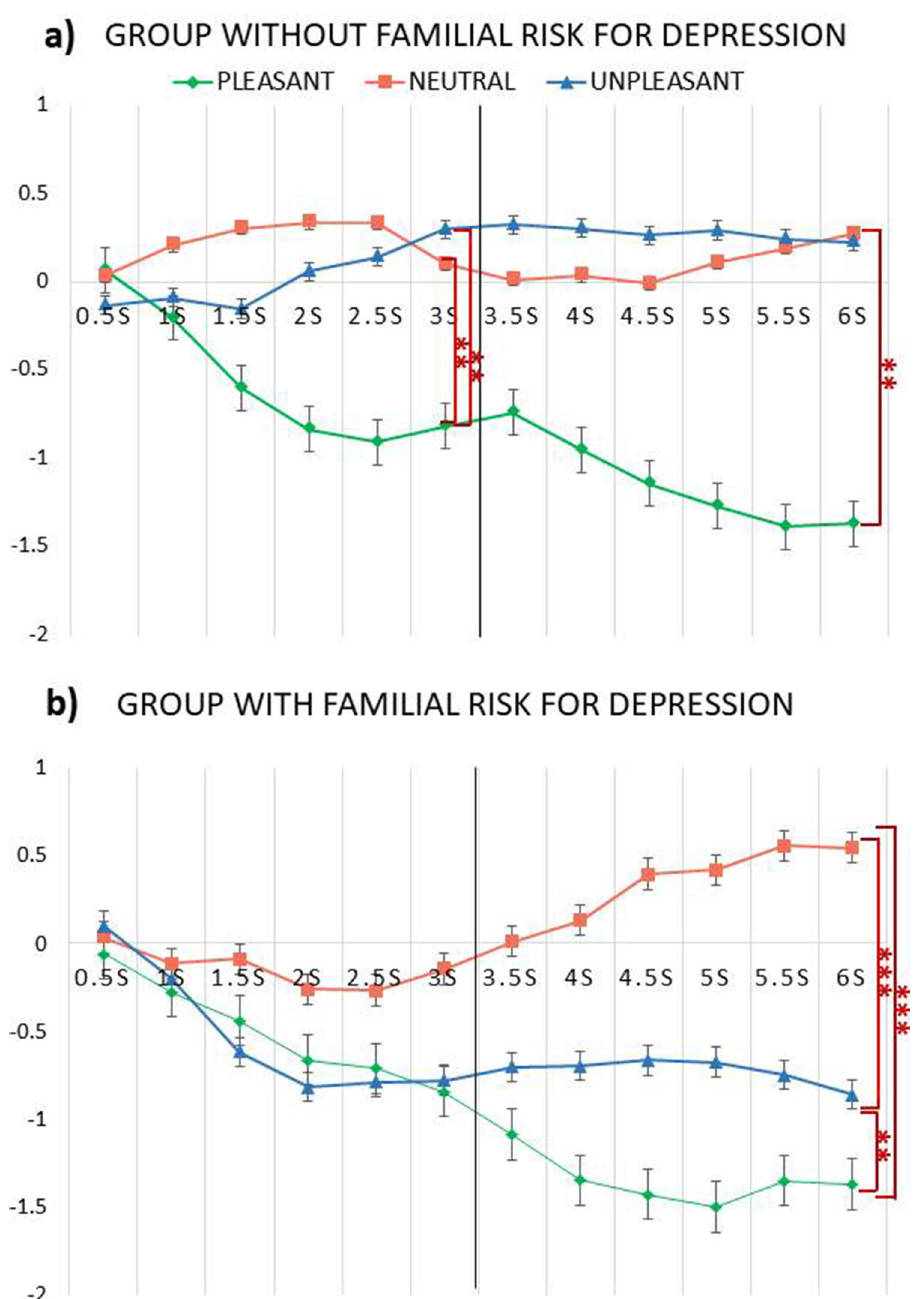
Figure 4. Averaged heart rate change during the viewing of pleasant, neutral, and unpleasant pictures in the group without ( a ) and with ( b ) familial risk for depression. Units are beats per minute (bpm) changes from 2 s baseline. Error bars represent ± standard error of the mean (SEM). ** p < .01; *** p <